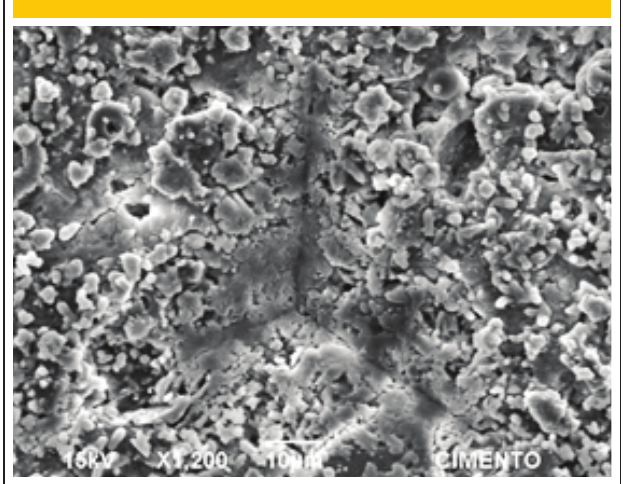
Figure 3 – Point image of the indentation 12